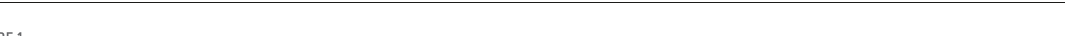
FIGURE1 scale bar: 30 mV and 200 ms). (G) Response of the parvalbumin-positive fast spiker interneuron to suprathreshold (5 mW, above) and a subthreshold (0.25 mW, below) paired 5 ms light pulses (RMP: –67 mV and –69 mV, respectively, scale bar: 20 mV, 5 mV, and 20 ms). The black trace represents the average, while the gray traces represent 4 consecutive sweeps. The delay between the two pulses was 60 ms (scale bar: 20 mV, 5 mV, and 20 ms).